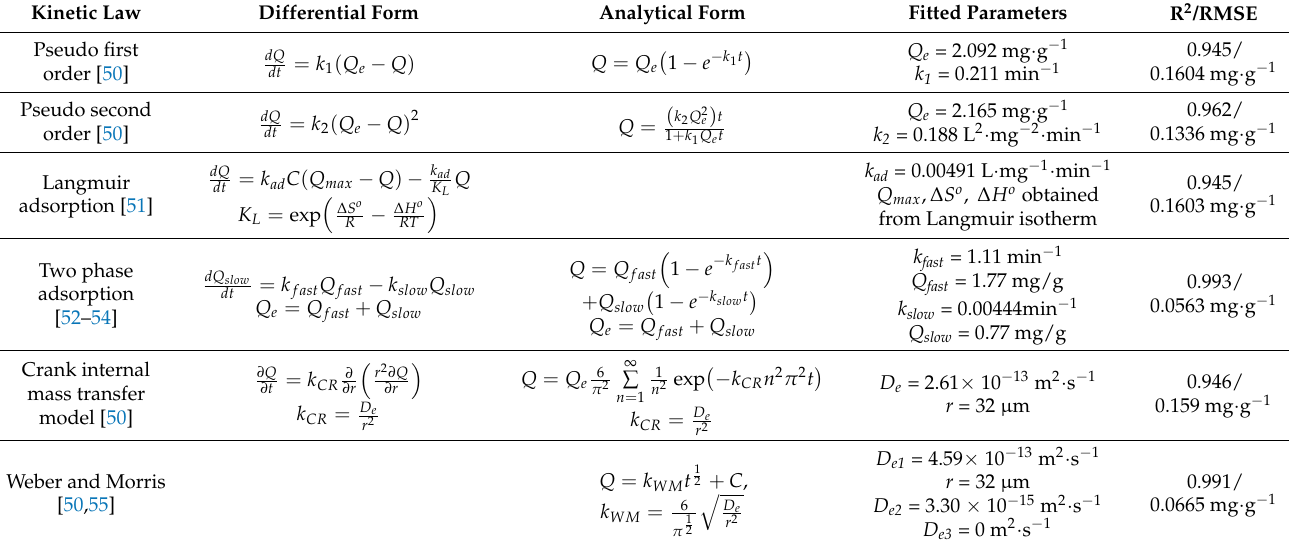
Table 5. Kinetic models for the adsorption of Cr(VI) by